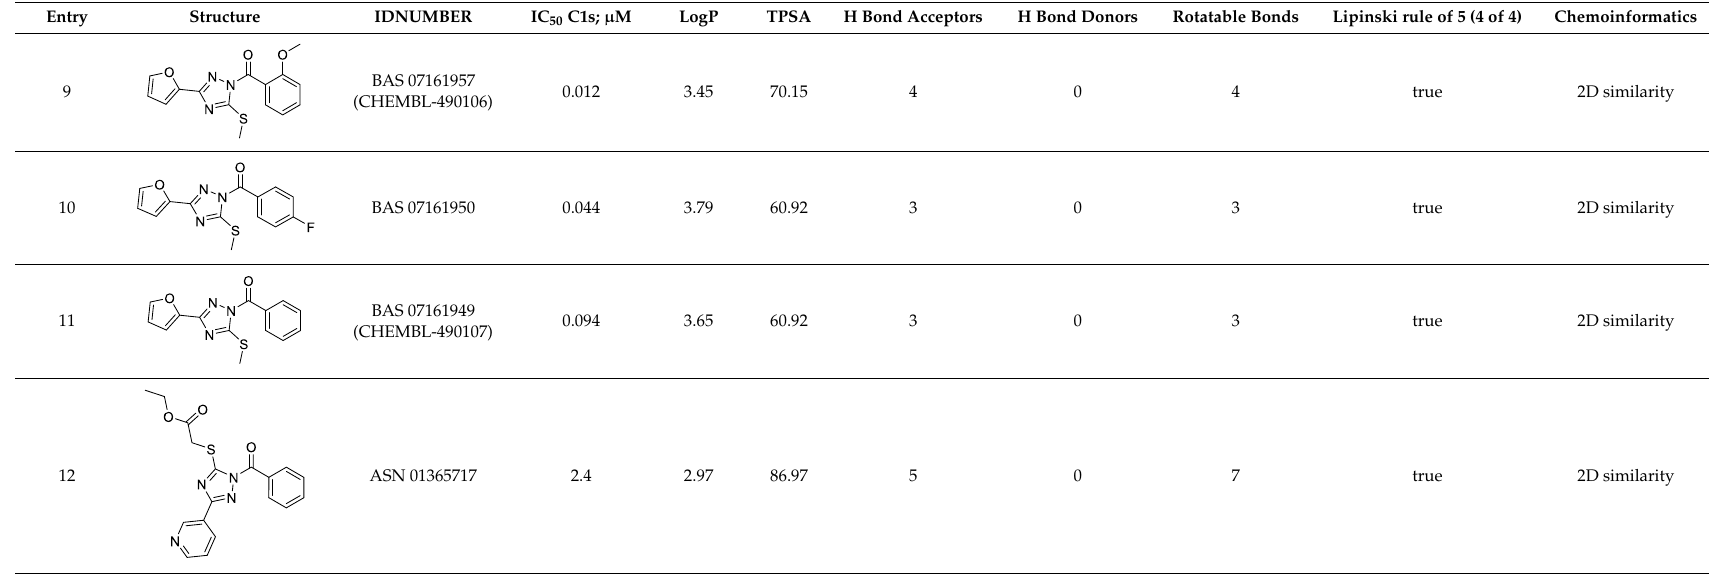
Table 2. Hit compounds derived from the 1,2,4-triazole chemotype.